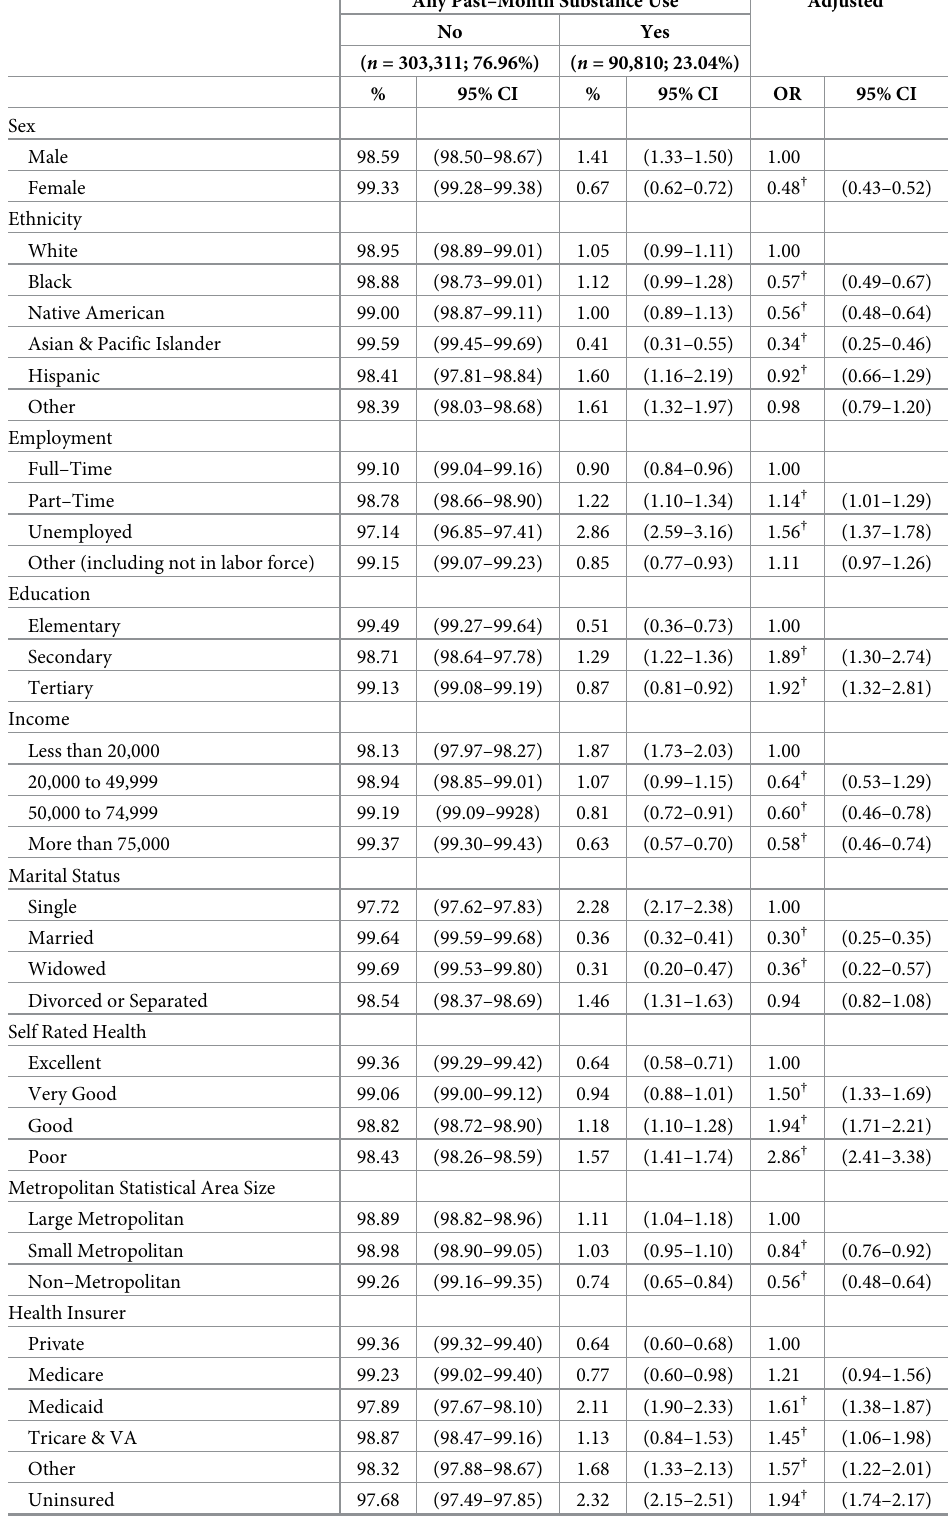
Table 4. Adjusted multiple logistic regression of socioeconomic, demographic, and health variables associated with past-month substance use and any-use for adults,